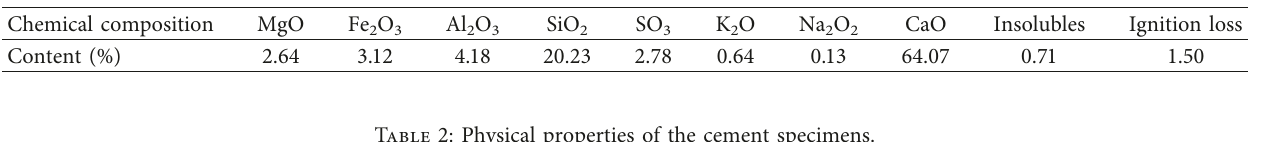
Table 1: Chemical compositions of the cement specimens.